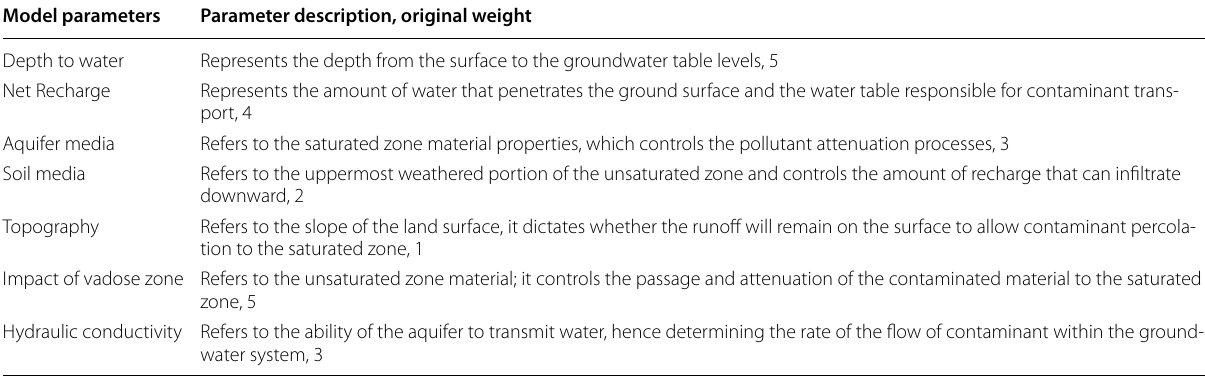
Table 2 Description and original weights of the intrinsic and specific model parameters (Babiker et al. 2005) Model